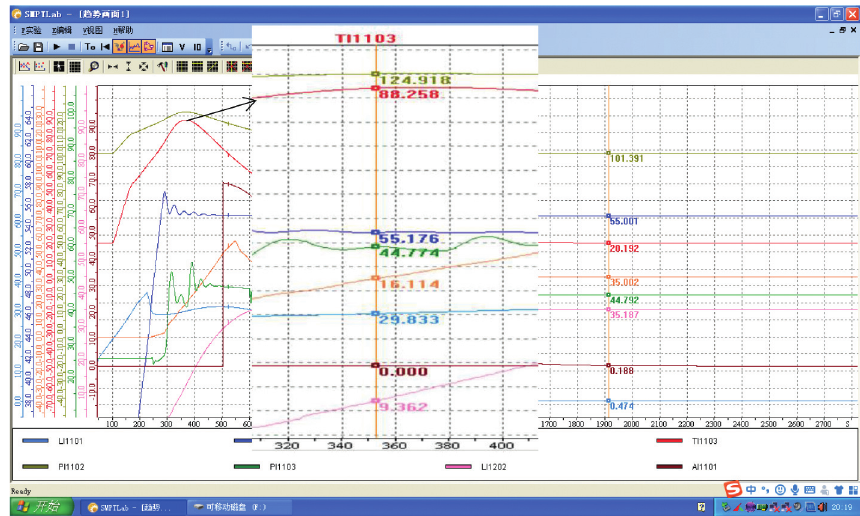
Figure 8: Original automatic disturbance rejection control iteration number 4000 of system trend graph.